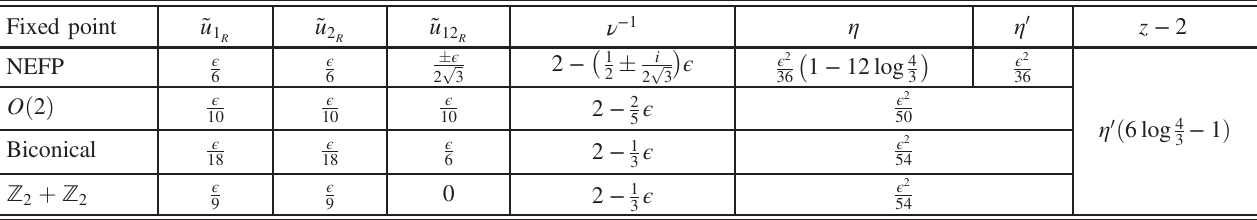
TABLE I. Fixed-point values of the coupling coefficients and critical exponents to the lowest order. In all cases, v NEFP, σ ¼ − 1 . The decoupled Z 2 þ Z 2 fixed point and the biconical fixed point in this case are unstable to the order O ð ϵ Þ , while the other two fixed points are stable to the same order. The Z 2 þ Z 2 and biconical fixed points exhibit the same critical behavior since they can be mapped to each other through a π = 4 rotation in the ϕ 1 − ϕ 2 plane. Fixed points involving the Gaussian fixed point are not included. Fixed